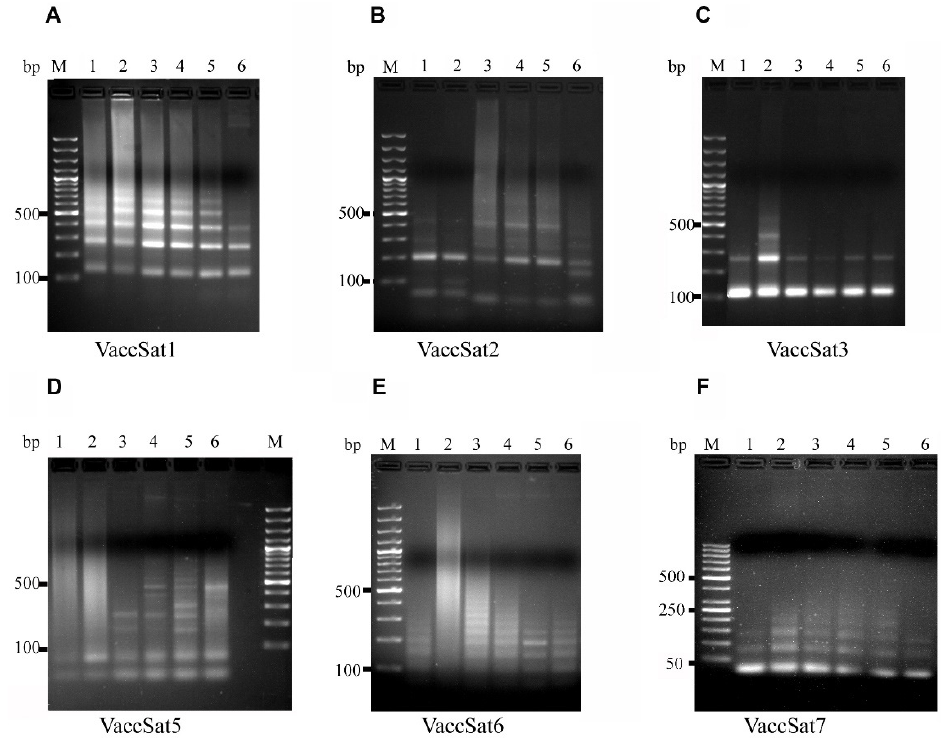
Figure 1. Amplification of Vaccinium satellites in different species using satellite-specific primers. ( A – C ) VaccSat 1–3, ( D – F ) VaccSat 5–7. The plant species used and molecular marker were represented in different lanes and are as follows: Lane 1: V. corymbosum , cultivar “Jubilee,” Lane 2: V. corymbosum cultivar “Misty,” Lane 3: V. arctostaphylos (elongated shaped fruit), Lane 4: V. arctostaphylos (round shaped fruit), Lane 5: V. myrtillus , Lane 6: V. uliginosum. Lane M: 100 bp/50 bp DNA marker.